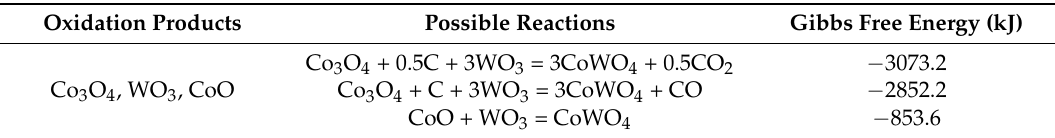
Table 4. Possible reactions with the oxidation products.